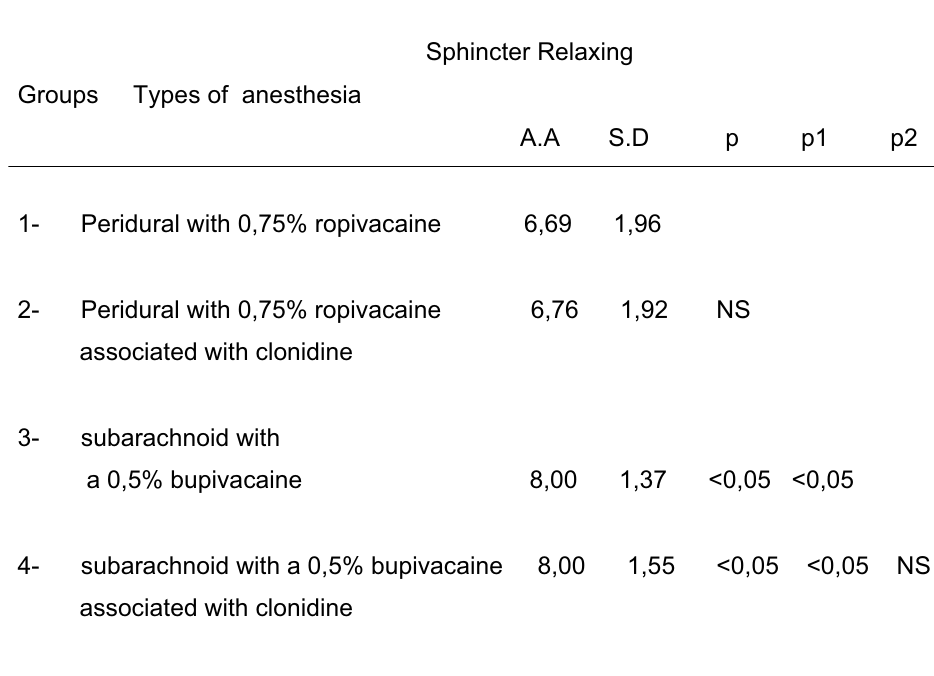
TABLE 2 - Degree of sphincter relaxing in patients undergone hemorroidectomy under peridural anesthesia with 0,75% ropivacaine associated or not with clonidine, and the subarachnoid anesthesia with 0,5% bupivacaine associated or not with